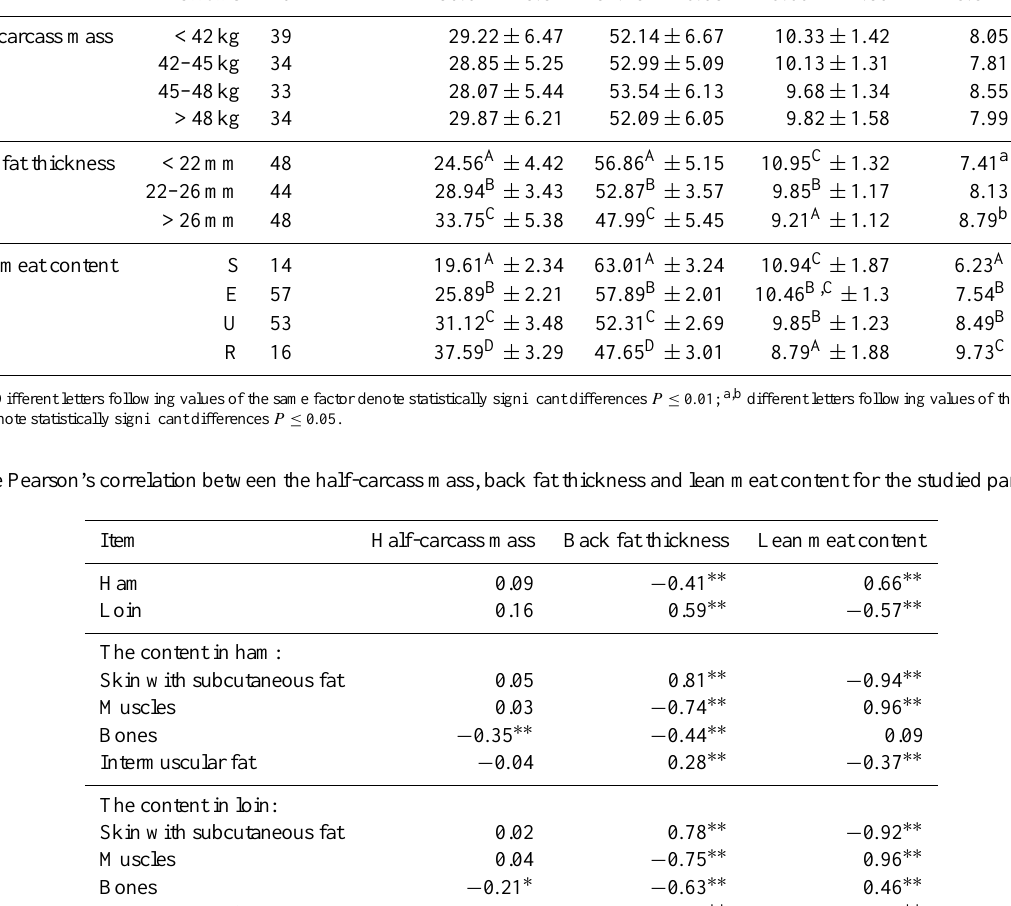
Table 3. The percentage content of loin dissection tissues, according to factors tested. Factor Class n The content of dissection tissues (%) Skin with subcutaneous fat Muscles Bones Sex